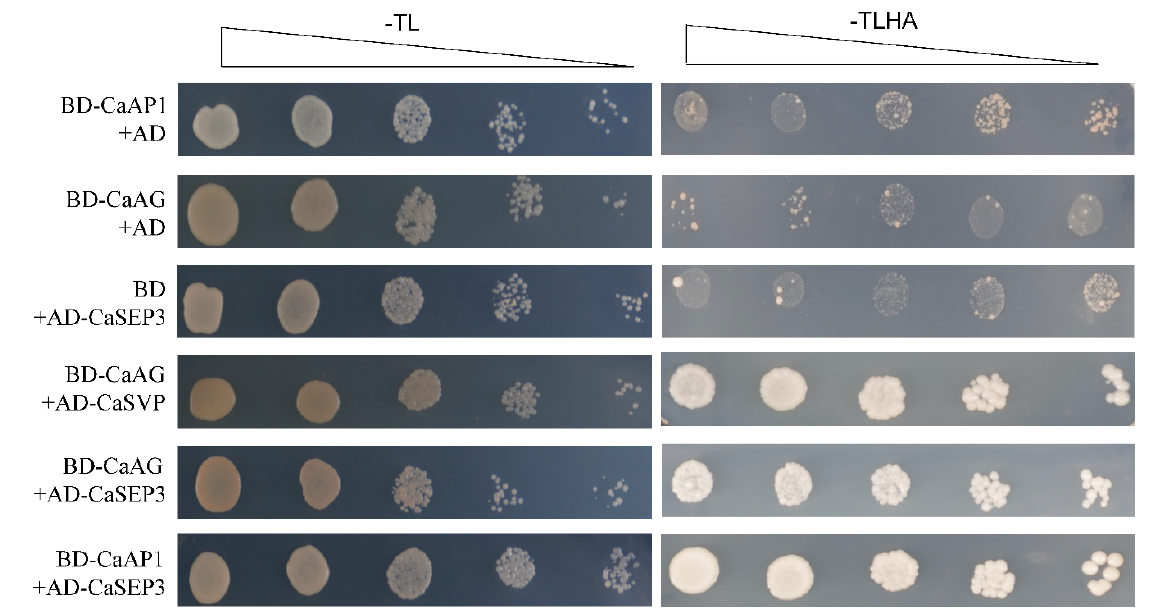
Figure 8. Yeast two-hybrid assays of interactions among CaAP1, CaAG, CaSVP, and CaSEP3